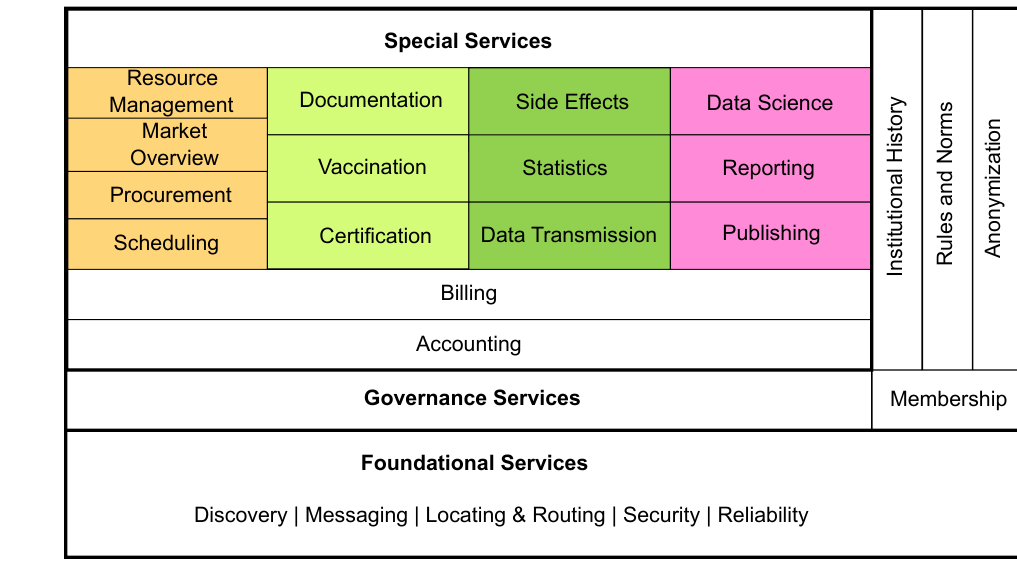
Figure 10. Service stack of the COVID-19-Vacc Platform (based on